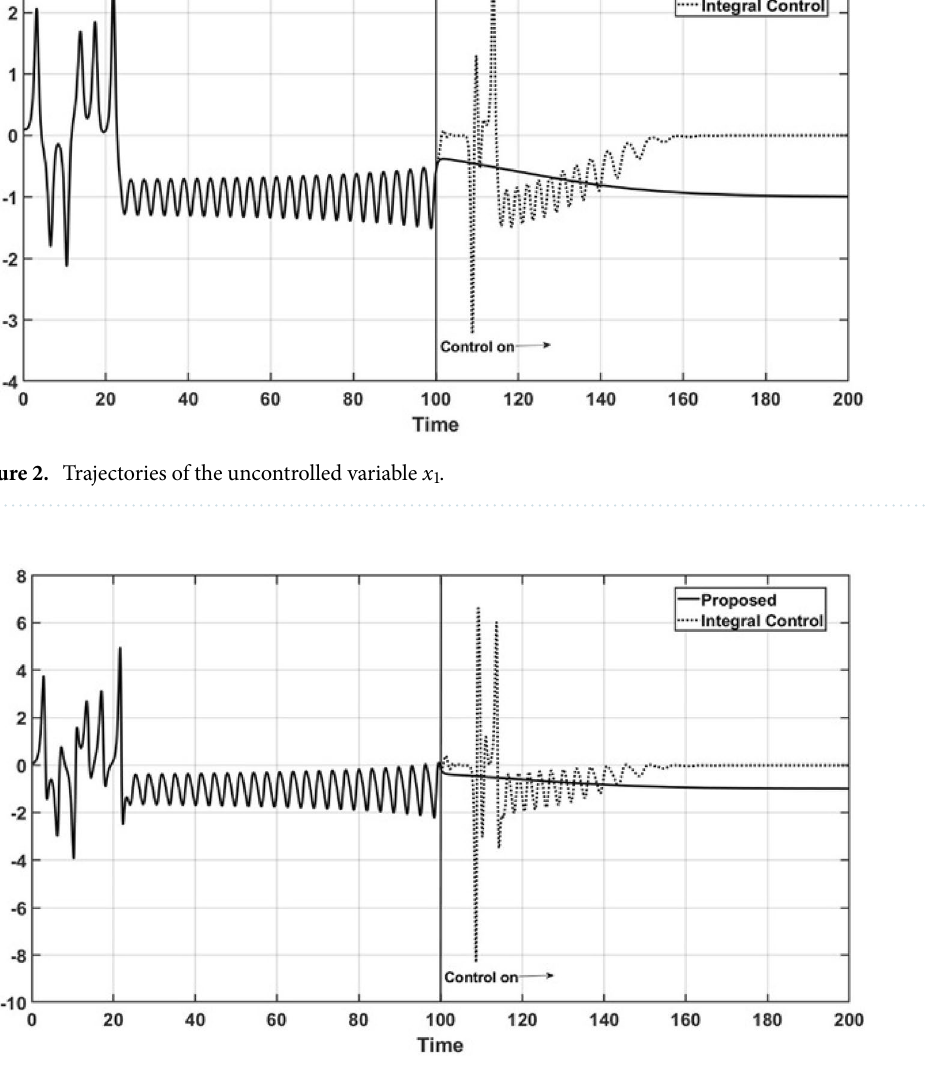
Figure 3. Trajectories of the uncontrolled variable x 2